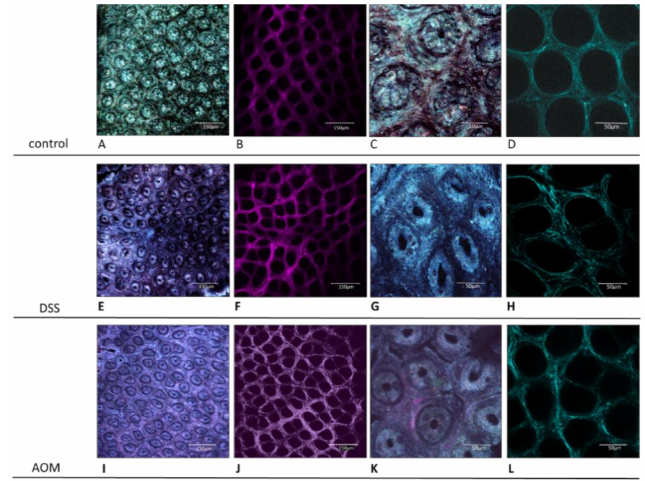
Figure 4. Healthy and treated rat colon mucosa evaluation by confocal microscopy. Confocal microscopy revealed more precisely the structural changes in the colon tissue related to the cryptal symmetry ( A , E , I ) and shape ( C , G , K ) and the collagen architecture ( B , D , F , H , J , L ). More irregular and dense organisation of collagen structures induced by both DSS ( F , H ) and AOM ( J , L ) in comparison with control animals ( B , D ). Inter-cryptal spaces were less regular and wider ( A , E , I ), and the shape of the crypts ( C , G , K ) resulted in being especially modified by the DSS treatment ( G ). ( A – D ) healthy rats; ( E–H ) DSS-treated rats; ( I – L ) AOM-treated rats; ( A , C , E , G , I , K ) reflectance confocal mode, 1-photon confocal microscopy; ( B , D , F , H , J , L ) second harmonic generation, multi-photon confocal microscopy. ( A , B , E , F , I , J ) HC PLAPO 20 × /0.70 lMM CS objective with water immersion; ( C , D , G , H , K , L ) HCX PL APO 63 × /1.20 W Corr water-immersion objective (WD 0.220